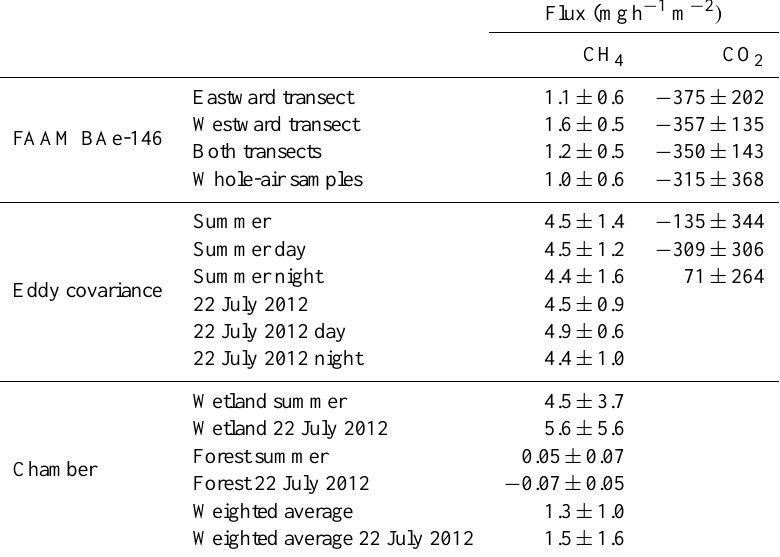
Table 2. Mean fluxes determined using the FAAM BAe-146, chamber and eddy covariance techniques. All uncertainties given are as one standard deviation (1 σ) . Chamber measurements are separated into the geometric mean of all seasonally averaged measurements and only those from the 22 July 2012. A weighted mean of the wetland and forest chamber fluxes is calculated using the number of occurrences of each land type within the east–west transect (Fig.